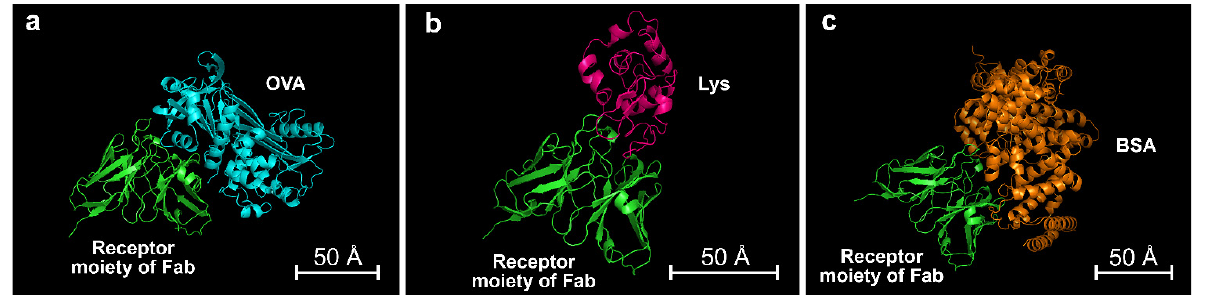
Figure 9. Most probable 3D structures obtained by molecular docking simulations for the complexes of ( a ) OVA, ( b ) Lys, and ( c ) BSA with anti-OVA. The scale bars represent 50 Å. Table 1. Predicted binding affinities and dissociation constants of complexes between anti-OVA and target proteins 1 . Target Protein